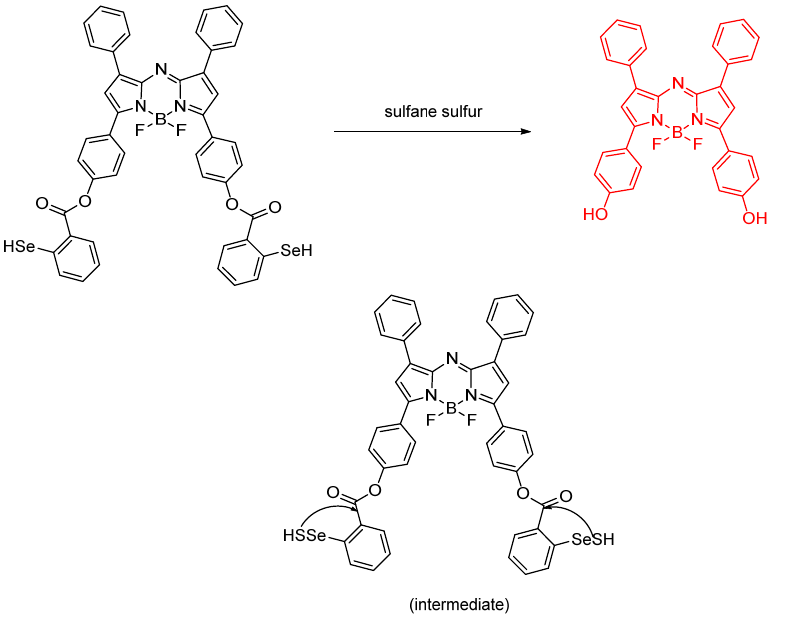
Figure 19. Near–infrared (NIR) chemosensor based on azo–BODIPY and diphenylselenol (BD–di– SeH) probes by Gao et al. for sulfane sulfur analyte detection.